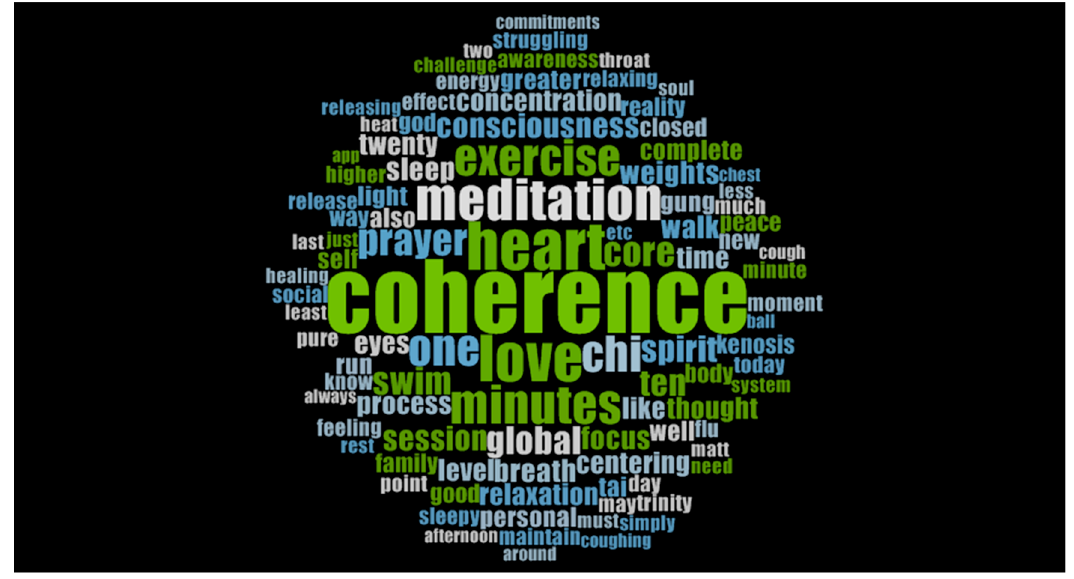
Figure 1 . NVivo Word Cloud? Figure 1. NVivo Word